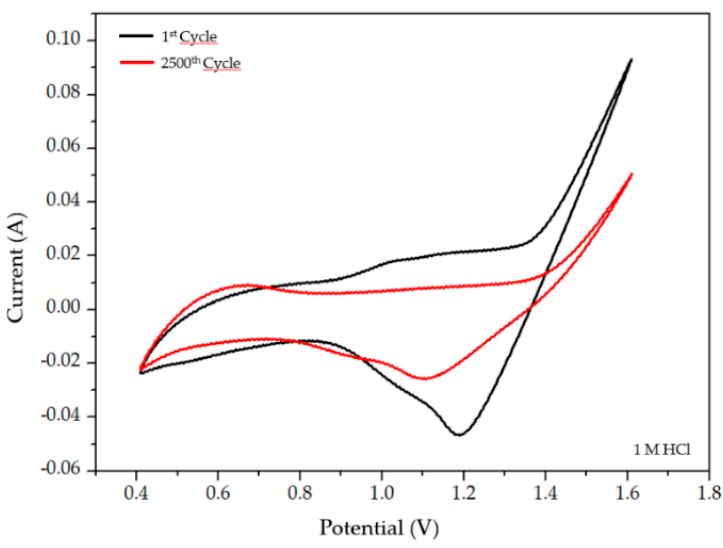
Figure 4. Voltametric profiles of Pt/C 40/60 electrode former used in a Westinghouse process. Black line corresponds to the 1st and red line to the 2500th cycle in a 1M HCl. Scan rate of 100 mV/s.